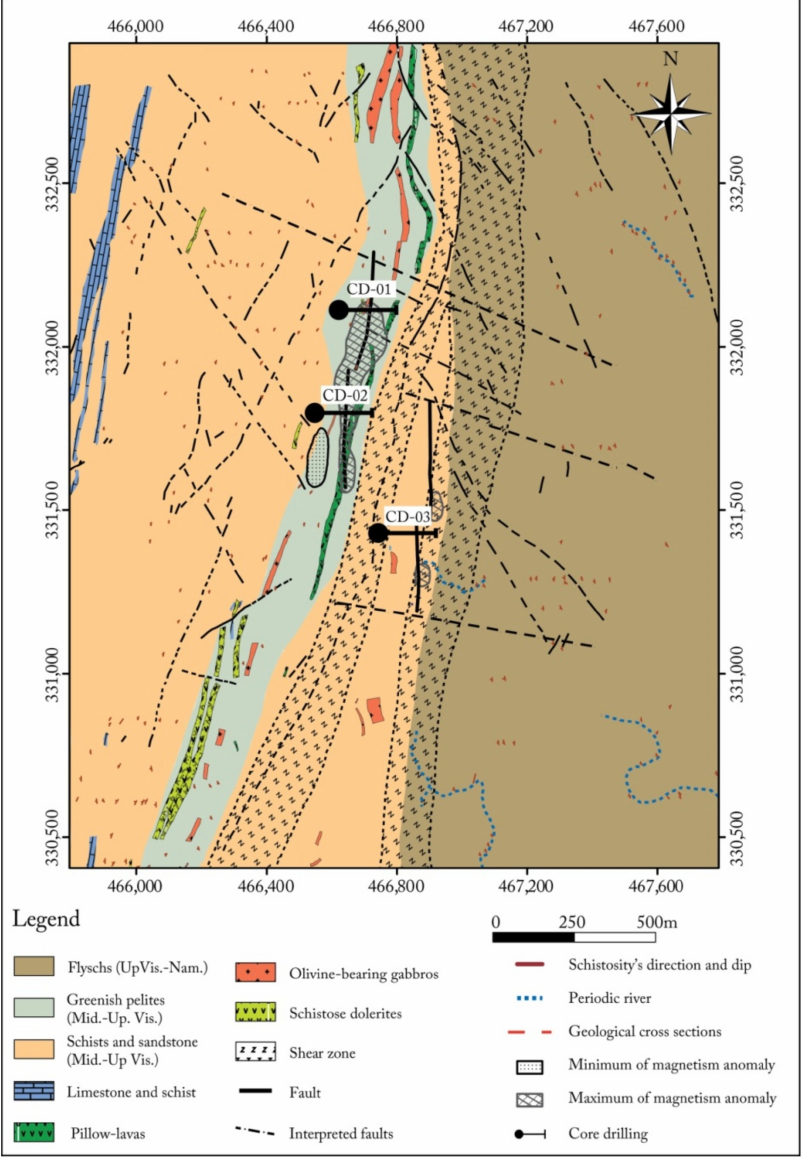
Figure 3. Geological map of the NNE-A (Mid.-UpVis.: Middle-Upper Visean, UpVis-Nam.: Upper